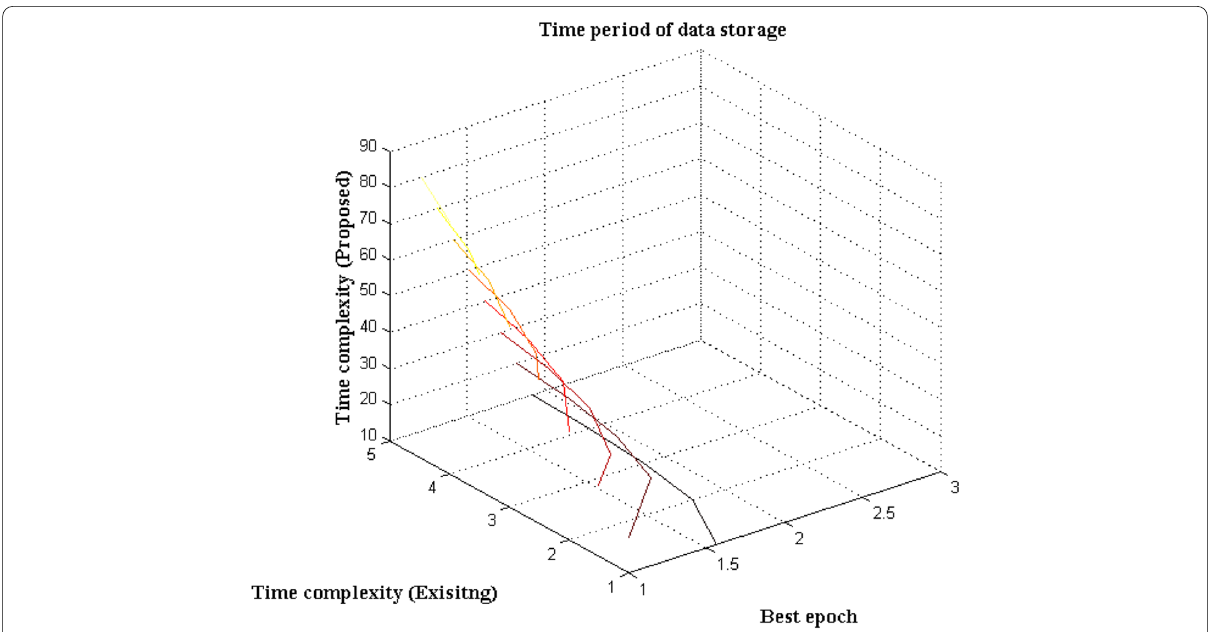
Fig. 8 Complexities in time periods